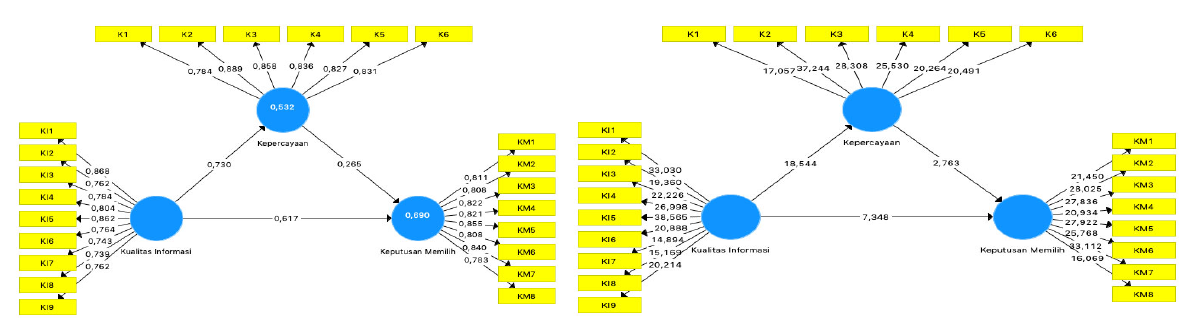
Fig. 1. Output Model PLS Algorithm Fig. 2. Bootstrapping PLS Output Model Source: Data performed with SmartPLS version 3 (2021)